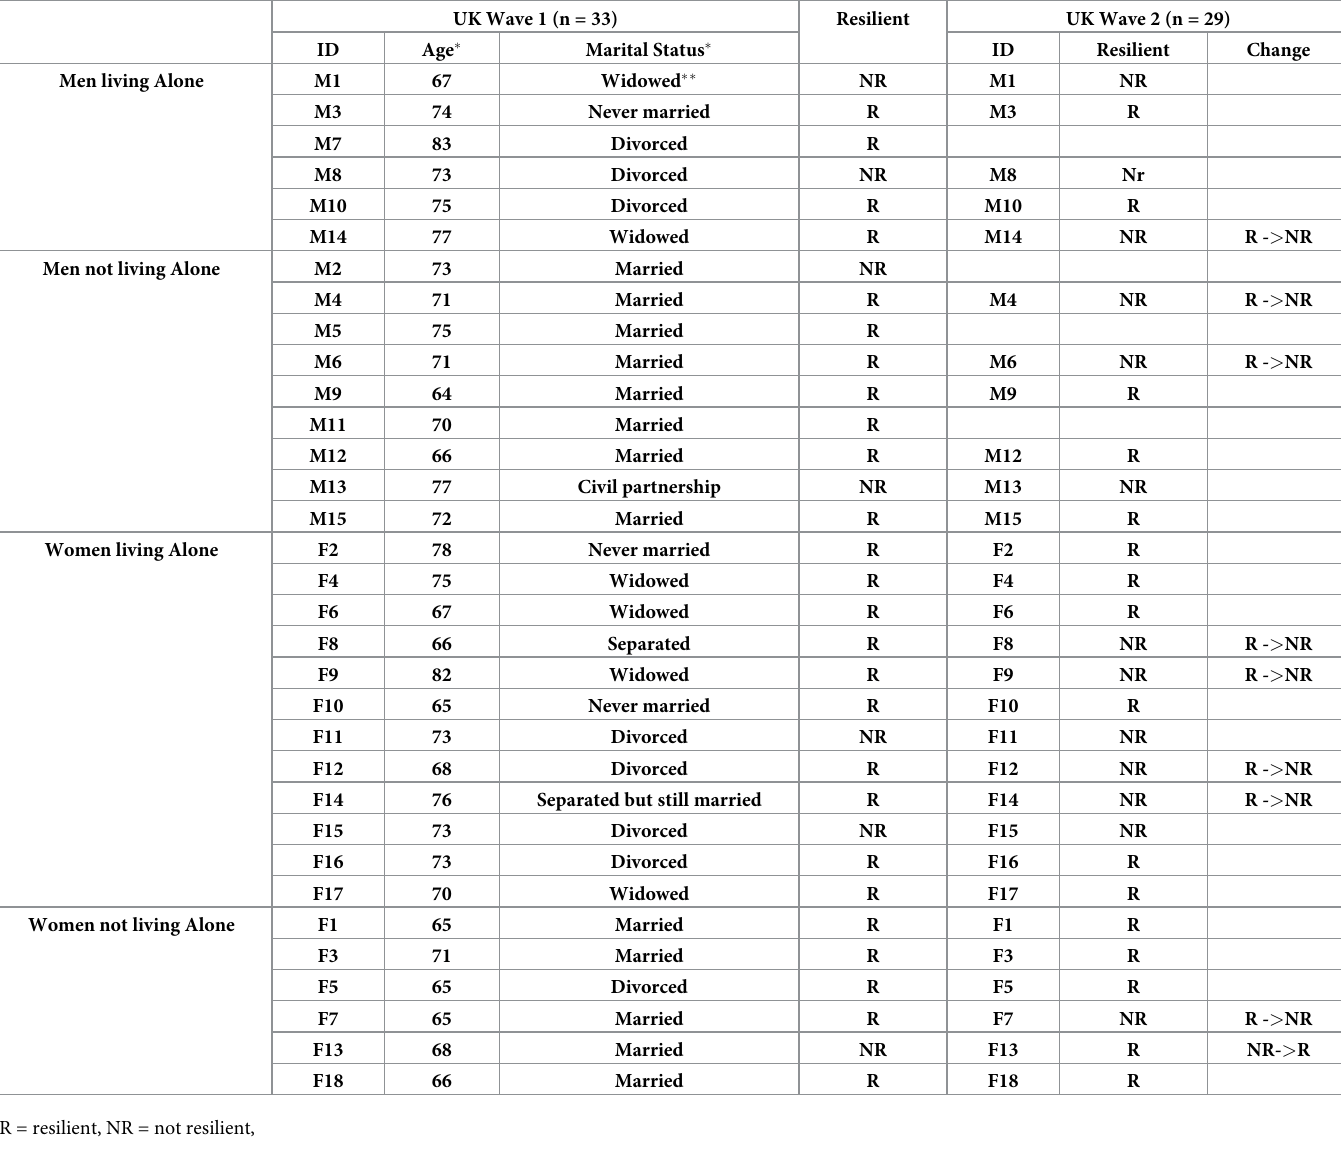
Table 1. Participants demographics Wave 1 and Wave 2 (including classification of resilience). UK Wave 1 (n =